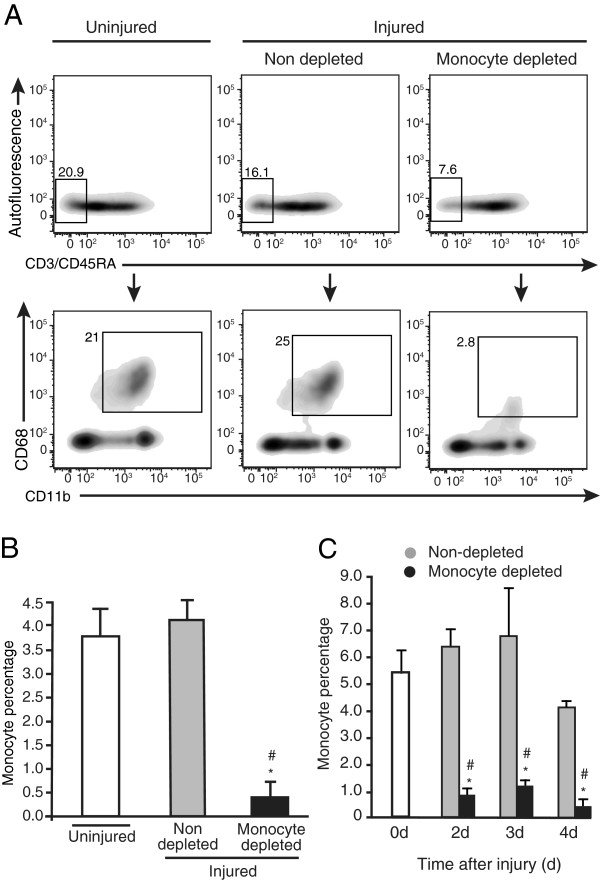
Liposome-encapsulated clodronate eliminates more than 80% of blood monocytes. (A) Rats received daily injections of liposome-encapsulated clodronate starting 24 h prior to intra-muscular injection of bupivacaine until euthanasia at 4 d post-injury. Clodronate treatment induces a decrease of the CD3-CD45RA- non-lymphoid cell frequency (A, upper lane), and of the frequency of CD11b+CD68+ monocytes found in the CD3-CD45RA- population (A, lower lane). Gates were set using either omission of primary antibodies (omission of CD3/CD45RA or CD11b) and using an isotype control for CD68. n = 3. (B) When expressed relatively to total PBMCs, the frequency of CD3-CD45RA-CD11b+CD68+ monocytes was decreased by 90% by the clodronate treatment in injured animals, in comparison to uninjured (*) and injured non-depleted (#) animals. Student’s t-test, p < 0.05. n = 3. (C) Using the same gating strategy, we shown that clodronate treatment significantly decreased the frequency of CD3-CD45RA-CD11b+CD68+ monocytes at 2 d and 3 d by 86% and 82%, respectively in injured animals, in comparison to uninjured (*) and injured non-depleted (#) animals. Student’s t-test, p < 0.05. n = 3.